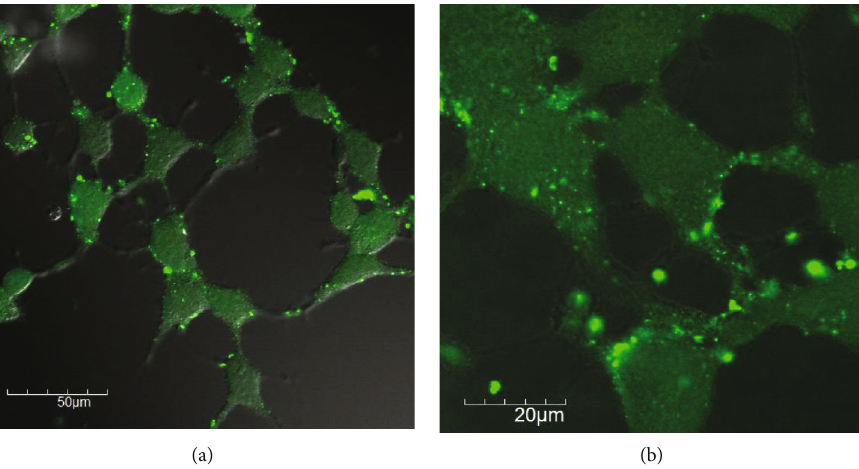
Figure 5: Intracellular incorporation of (a) FITC-labelled HSA (100 μ M) or (b) FITC-labelled CT – HSA (100 μ M). This observation was performed using confocal laser scanning